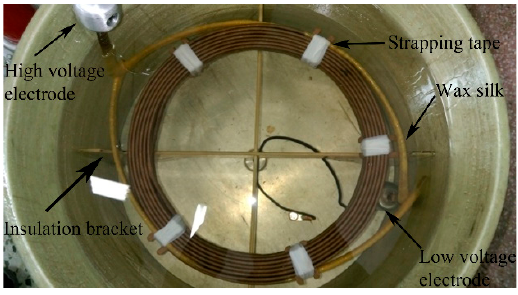
Figure 4. The structure of coil model.